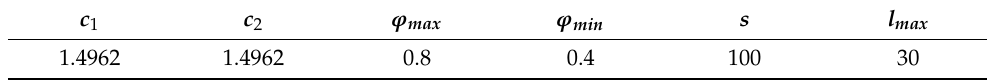
Table 1. Parameters of GSPSO algorithm.